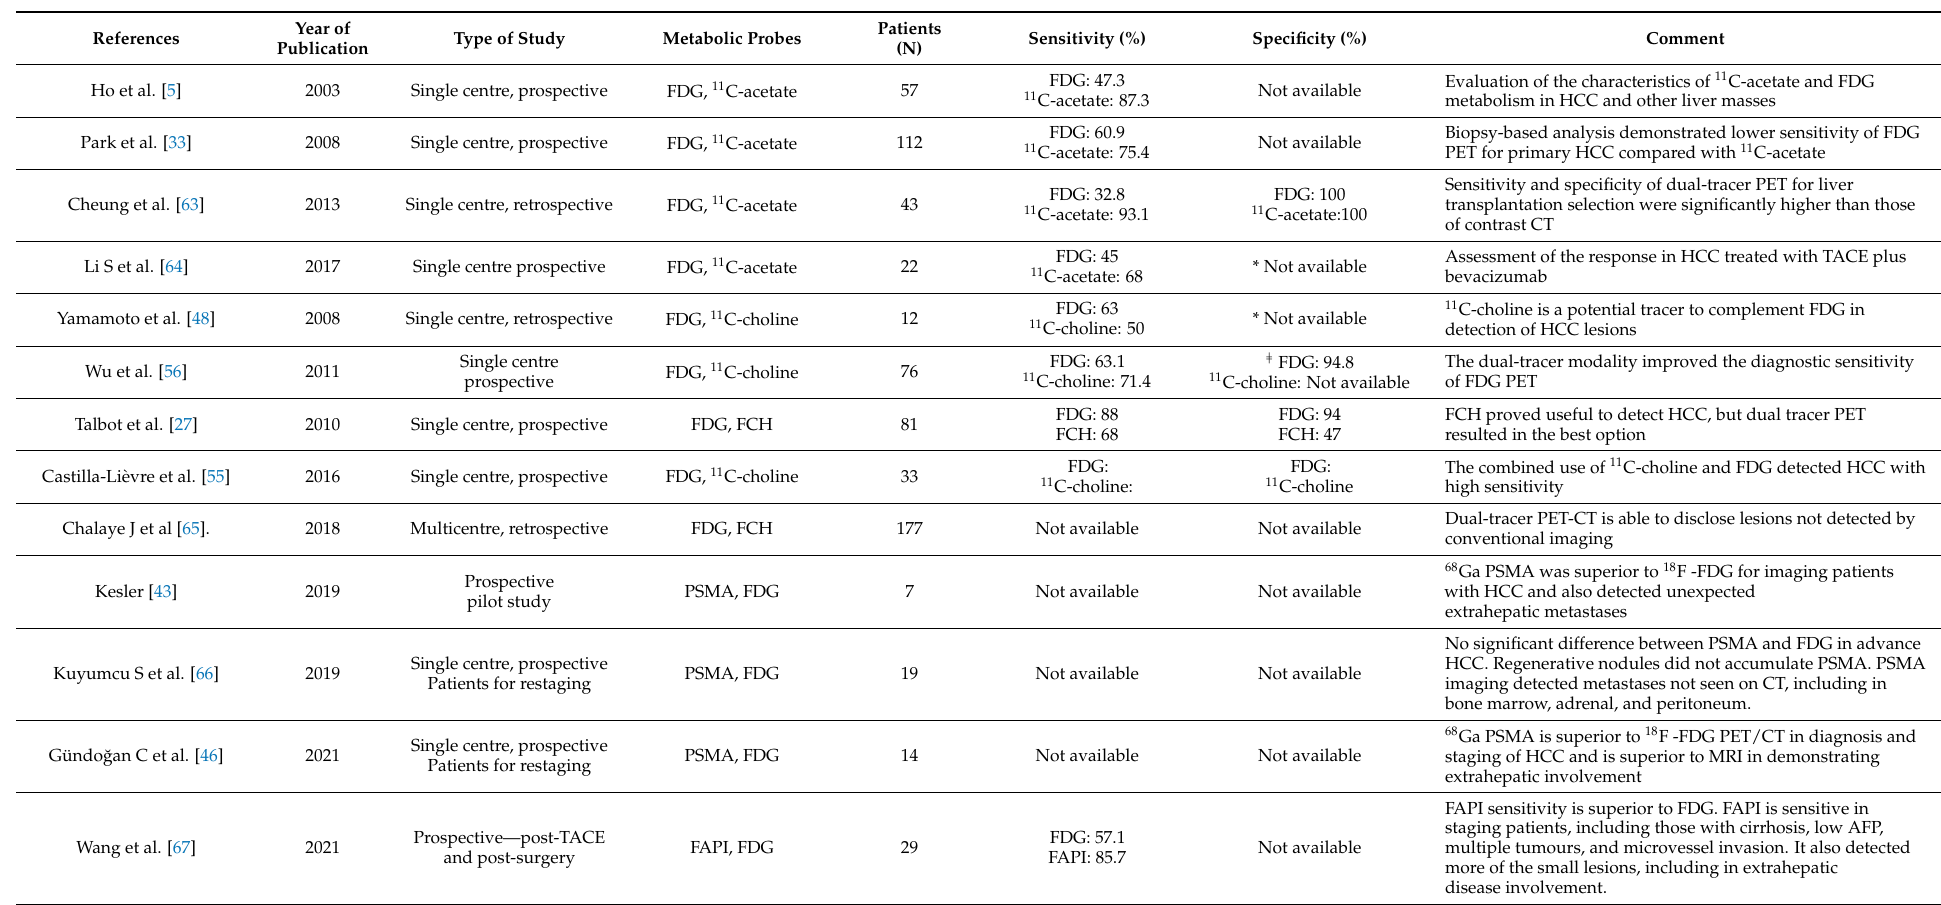
Table 1. Summary of manuscripts comparing FDG and other PET probes for imaging HCC. * Only patients with HCC were selected; } Only calculated for extrahepatic metastases; Adapted from Filipi et al.